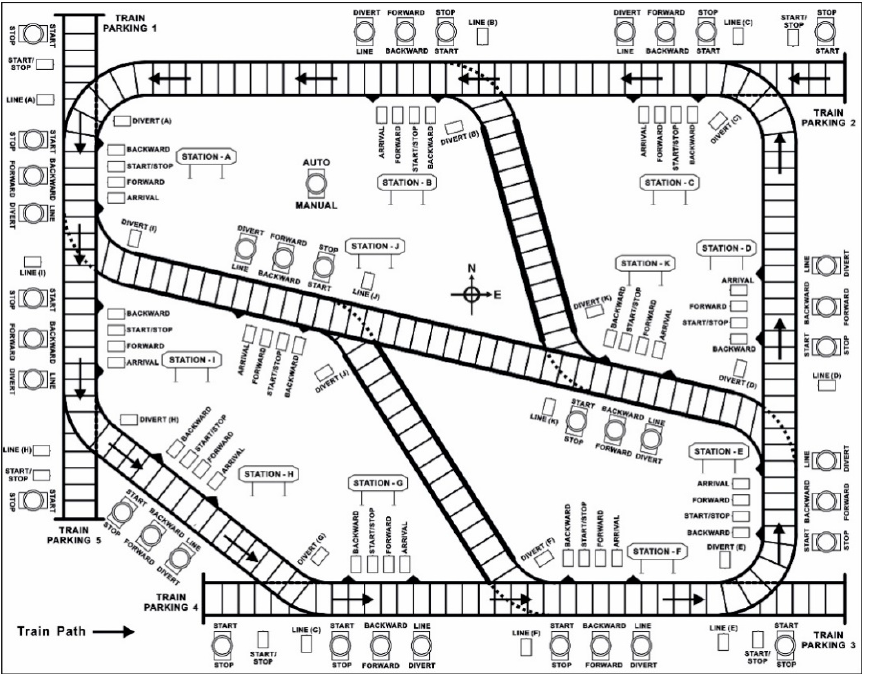
Figure 4. Single train navigation in the rail-network.